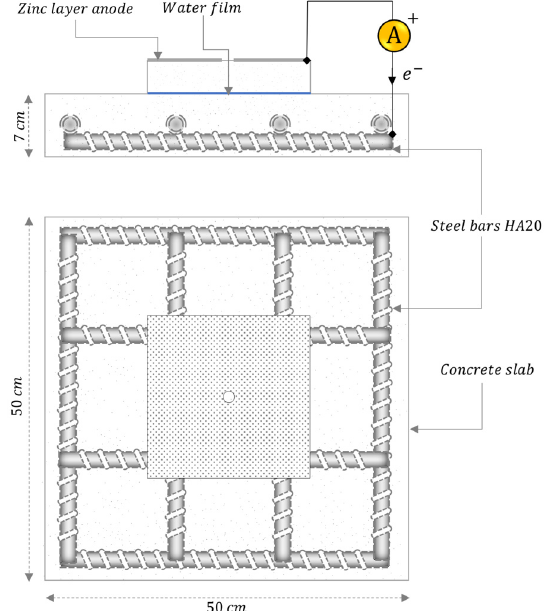
Figure 3. Experimental protocol for natural ageing of ZLA by galvanic coupling with an external passive steel